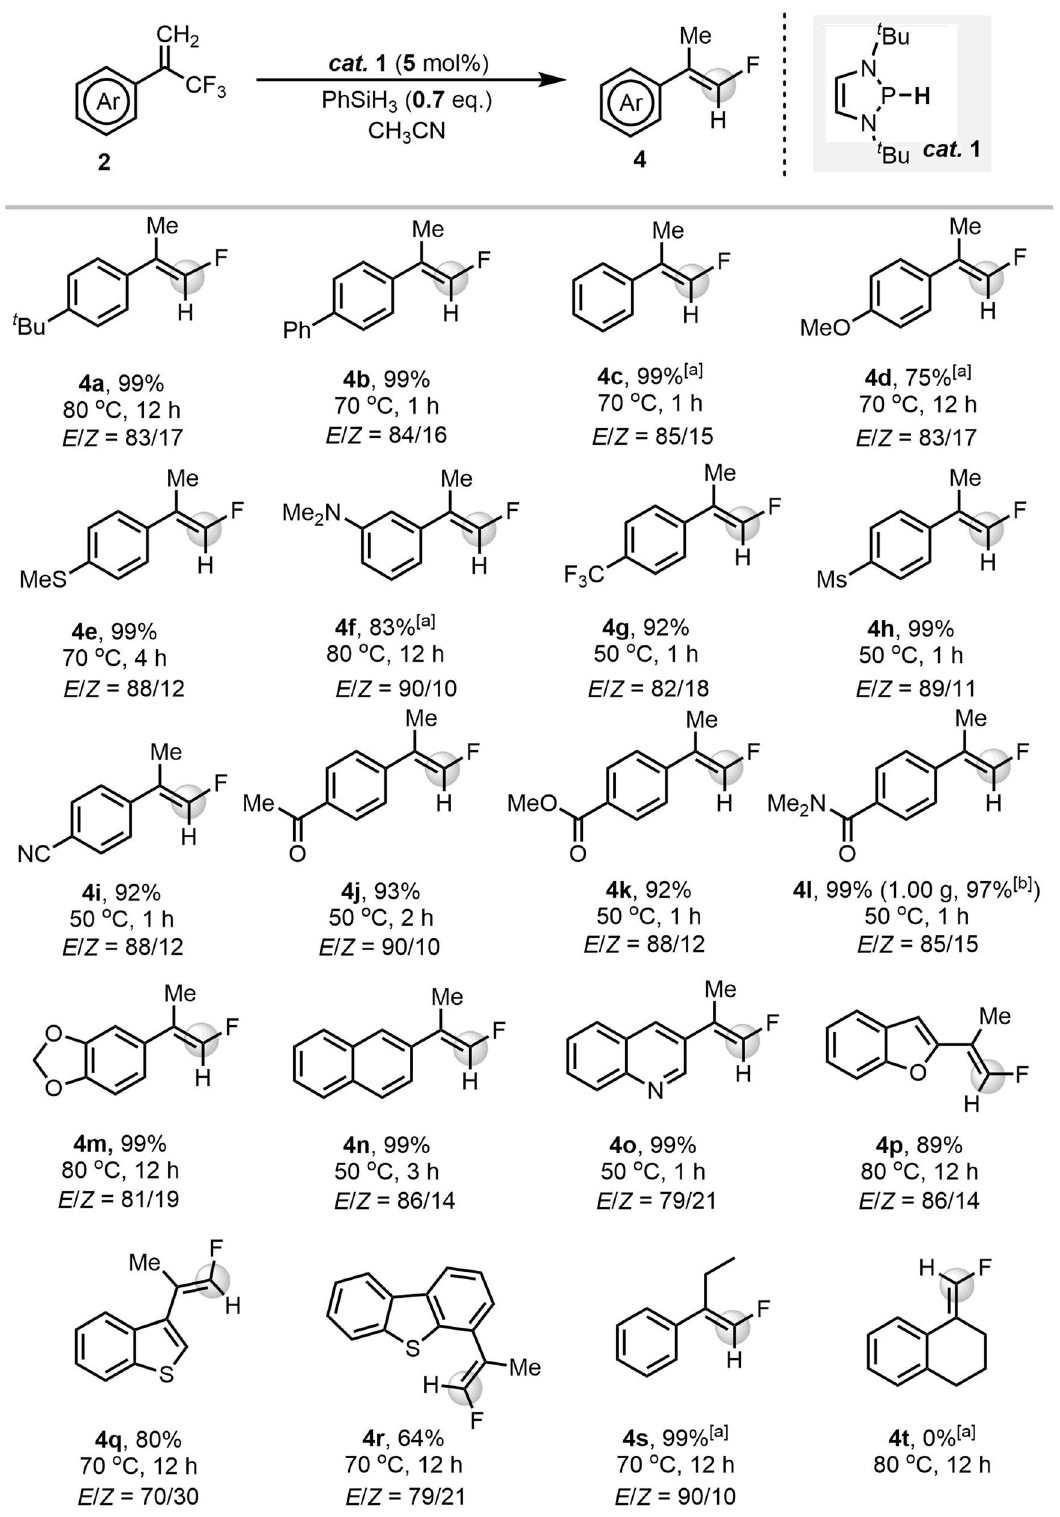
Fig. 5 Synthesis of terminal mono fl uoroalkenes by diazaphospholene-catalyzed HDF of tri fl uoromethylalkenes. General reaction conditions: 2 (0.3 mmol), 1 (5 mol%), PhSiH 3 (0.7 equiv.), and CH 3 CN (1 mL) were mixed in a tube under Ar. Isolated yields were given. The E / Z ratios were determined by 19 F NMR spectroscopy. [a] Determined by 19 F NMR spectroscopy. [b] Isolated yield for gram-scale synthesis: 2 l (5.0 mmol), 1 (5 mol%), PhSiH 3 (0.7 equiv.), CH 3 CN (5 mL), 50 o C, 3